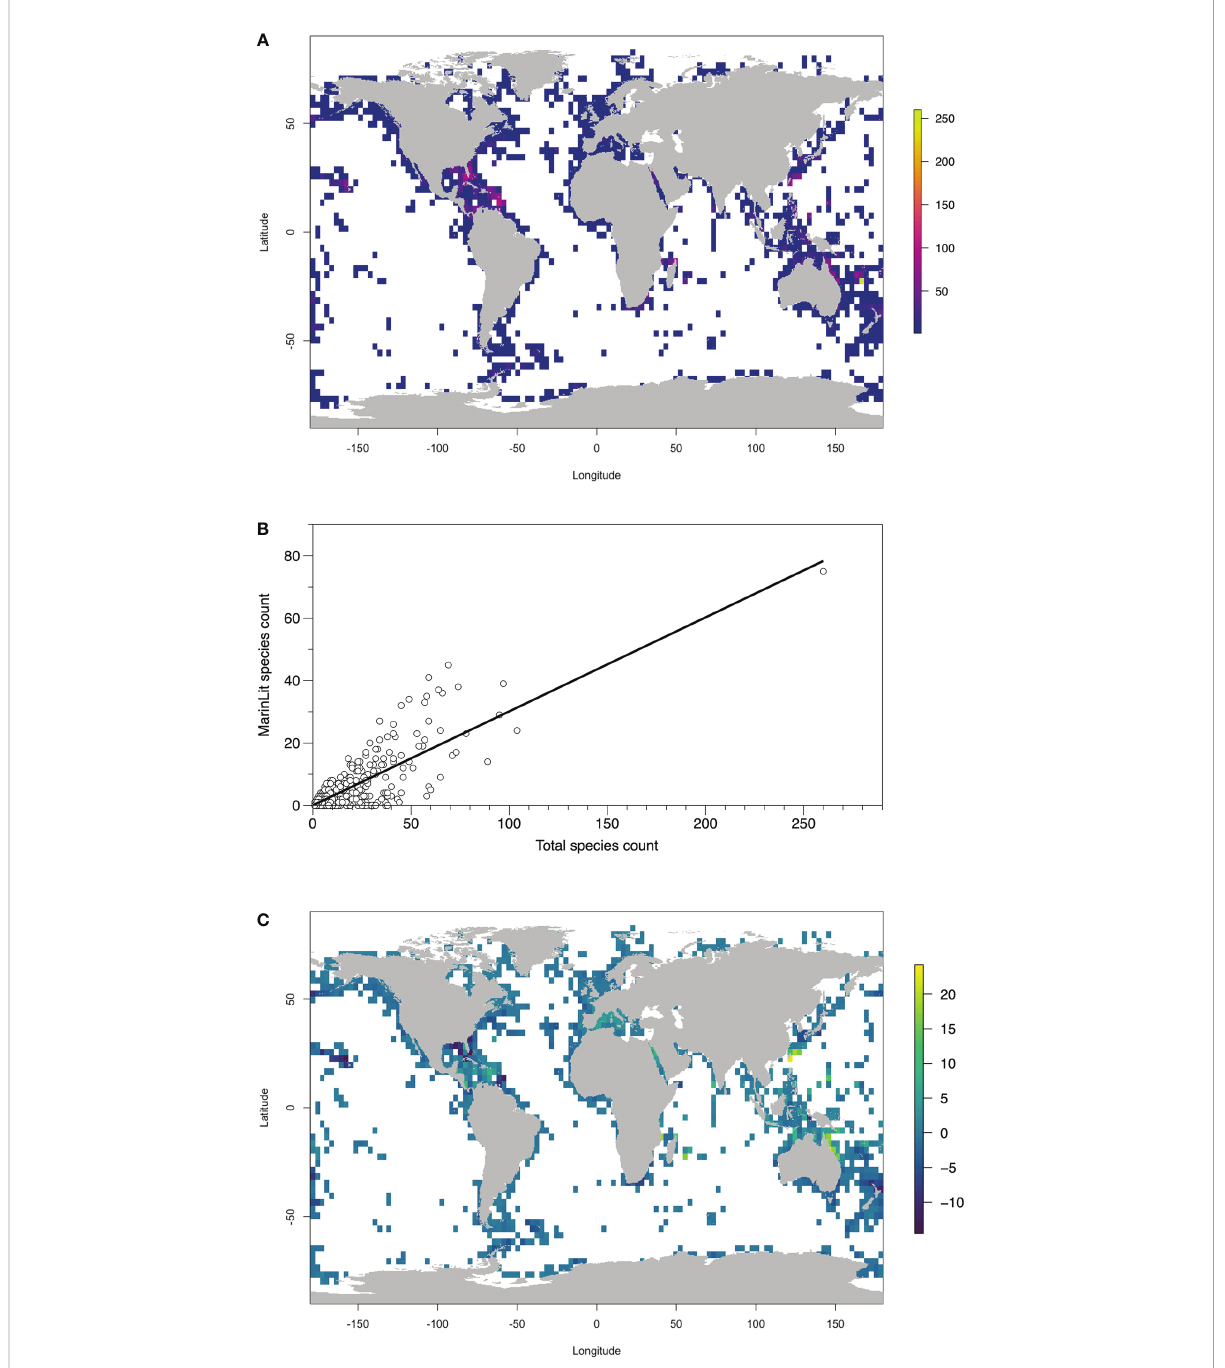
FIGURE 4 (A) Distribution of Alcyonacea species records in GBIF in 3° x 3° areas. (B) Relationship between number of species with at least one MarinLit compound and the total species count in each 3° x 3° area. Fitted line is linear regression through origin, r 2 72.6%. (C) Pattern of residuals from panel B, indicating areas where the proportion of species with a MarinLit compound is higher or lower than